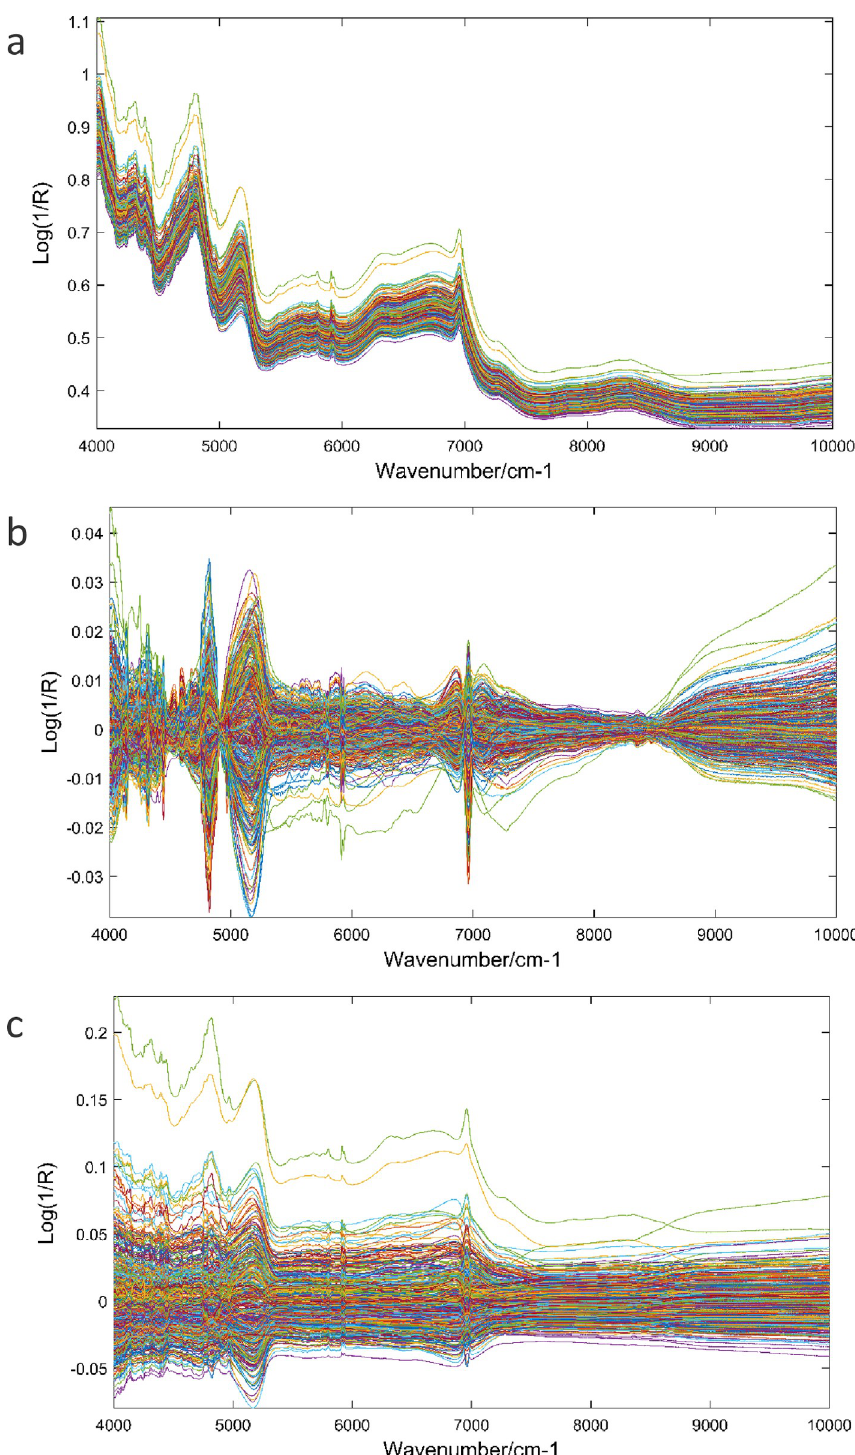
Fig 1. Sugarcane samples raw spectra (a) and pre-processed spectra for fiber content (b), and sucrose content (c).